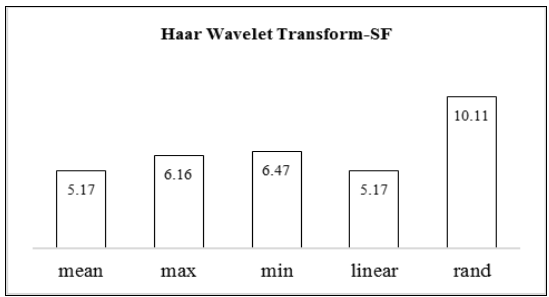
Figure 8. Spatial frequency of different filters